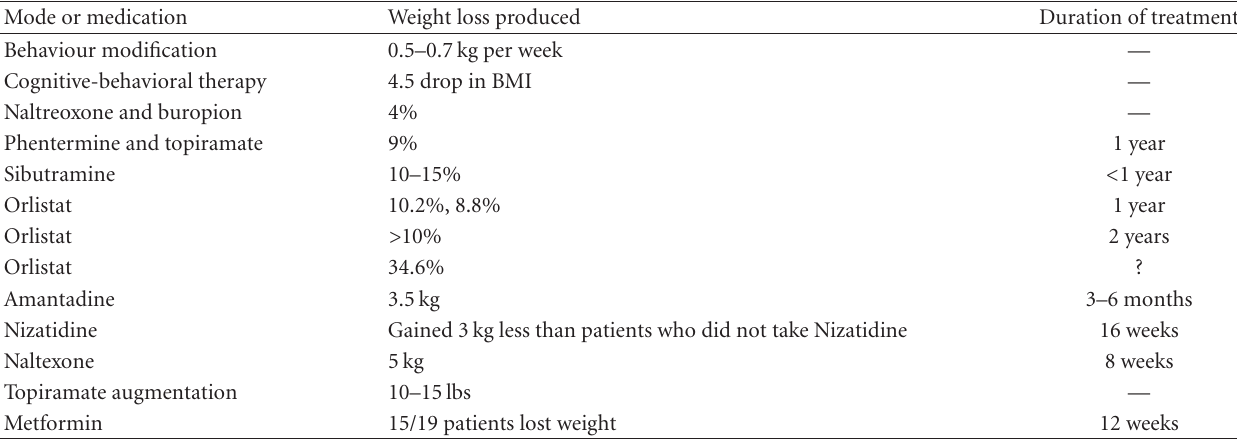
Table 1: Weight gain treatment